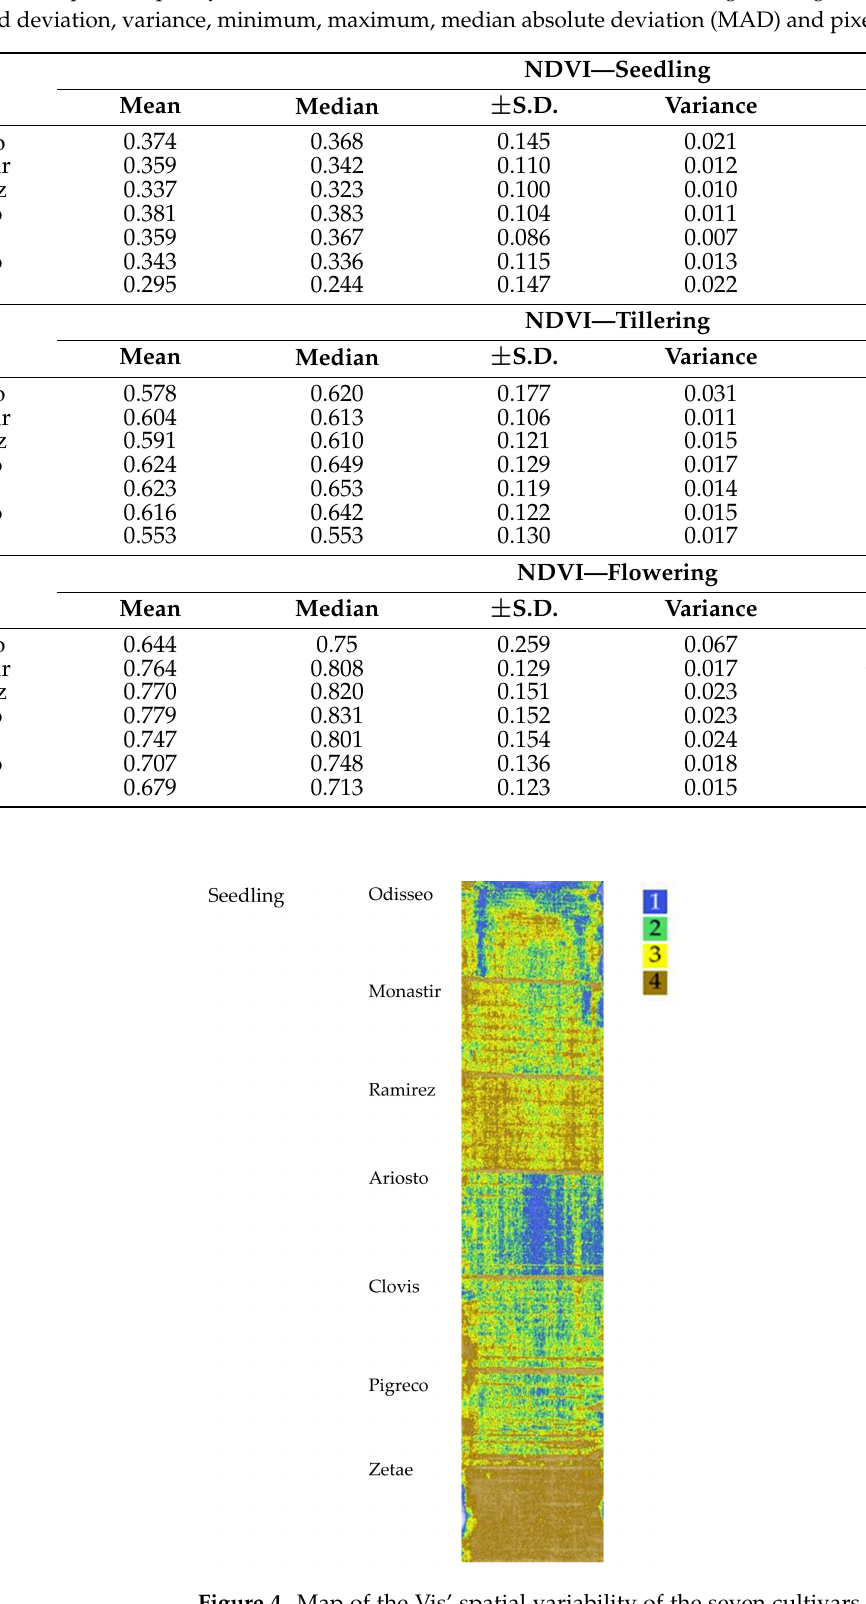
Figure 4. Map of the Vis’ spatial variability of the seven cultivars clustered by Ward’s method at seedling. Cluster 1 indicates the highest VI values, while cluster 4 indicates the